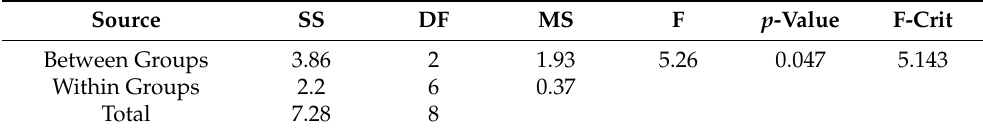
Table 8. Variance analysis of influence of weeding operation speed on seedling injury rate.